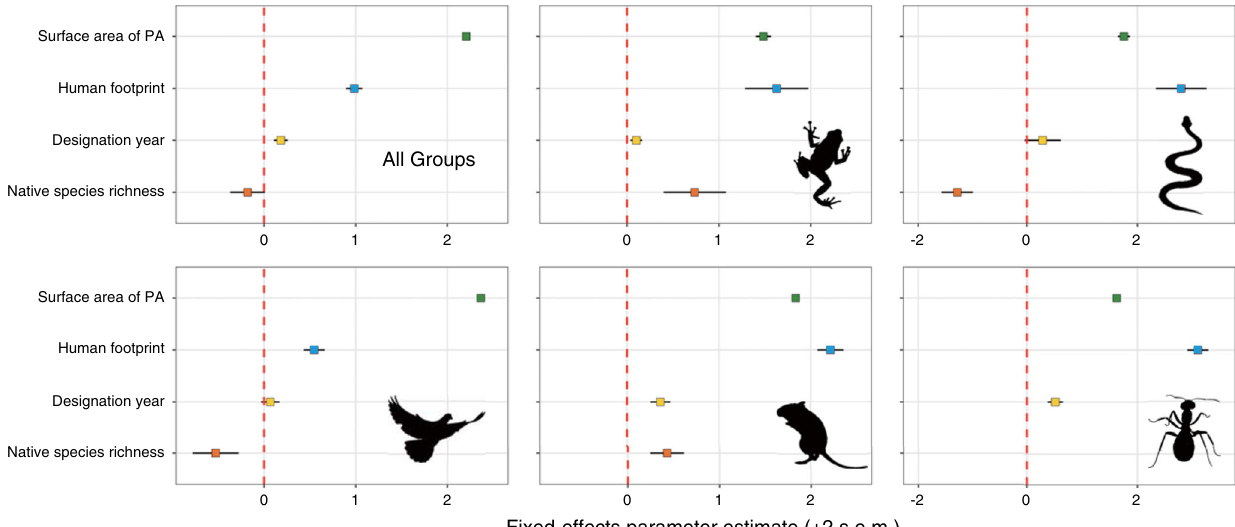
Fig. 5 Fixed-effect parameter estimates of surface area, designation year, native species richness and human footprint on richness of established alien animal species across taxonomic groups. Estimates of effects were obtained from zero-in fl ated negative binomial mixed-effects models with four abiotic, biotic and human activity factors as fi xed effects and country identity as a nested random effect. Note that native species richness was used only in the model for vertebrate groups due to the unavailability of invertebrate native distribution data. A constant of 1 was added to each variable prior to log transformation. Credit: Tianjian Song (animal